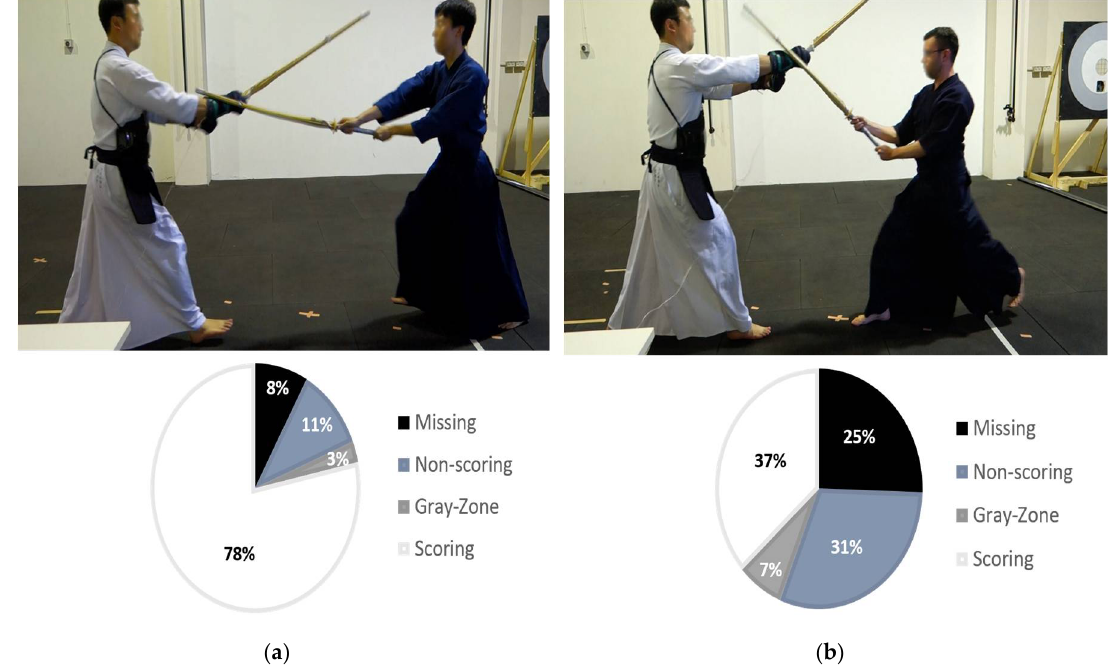
Figure 4. Photos of the Debana Kote kendo motion and pie chart summarising the percentage of scoring, grey-zone, non-scoring and missing the target in ( a ) Dan grade; ( b ) Kyu